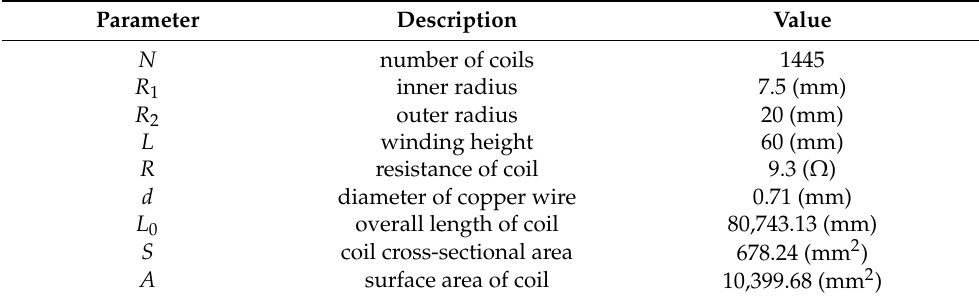
Table 1. Related parameters of electromagnetic actuators.